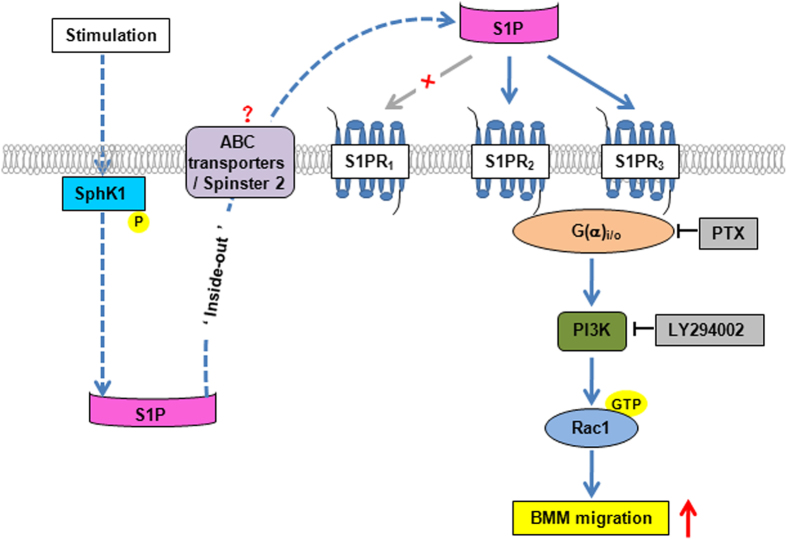
Scheme of BMM migration induced by S1P/S1PR2/3.S1P exerts a powerful migratory effect on BMMs via S1PR2 and S1PR3, which involves the activation of G(α)i/o, PI3K and Rac1 signaling pathways.